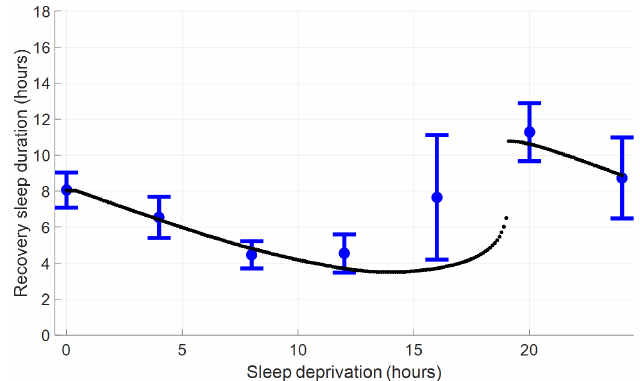
Figure 2. The recovery sleep duration to the duration of sleep deprivation after spontaneous sleep time. The blue symbols show the means and standard deviations of experimental data in [13] and the black nodes demonstrate the simulation results of the three-process